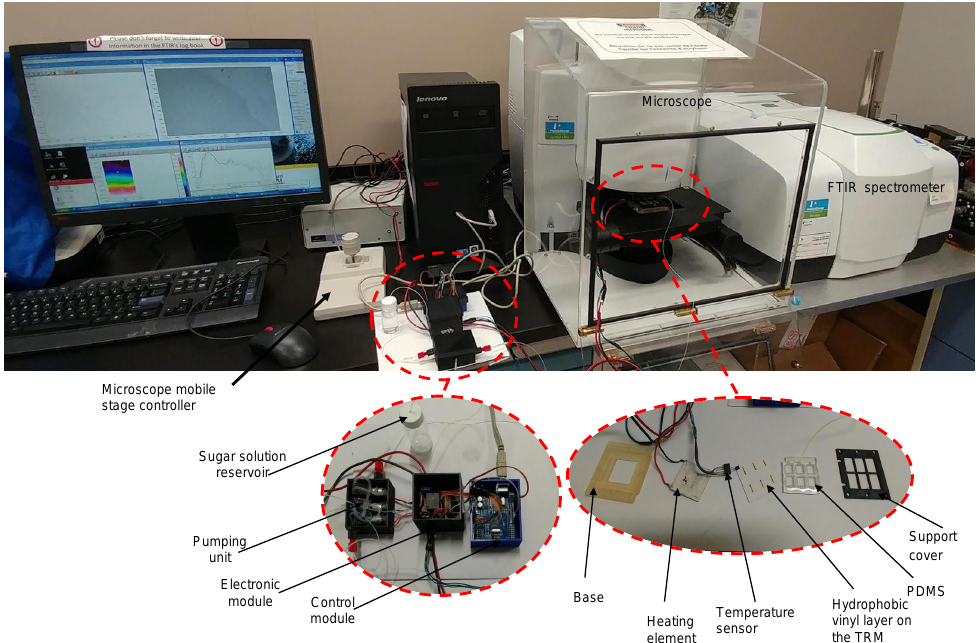
Figure 5. Experimental setup for sugar identification and quantification based on a microscope-FTIR spectrometer with the new designed microfluidic device.